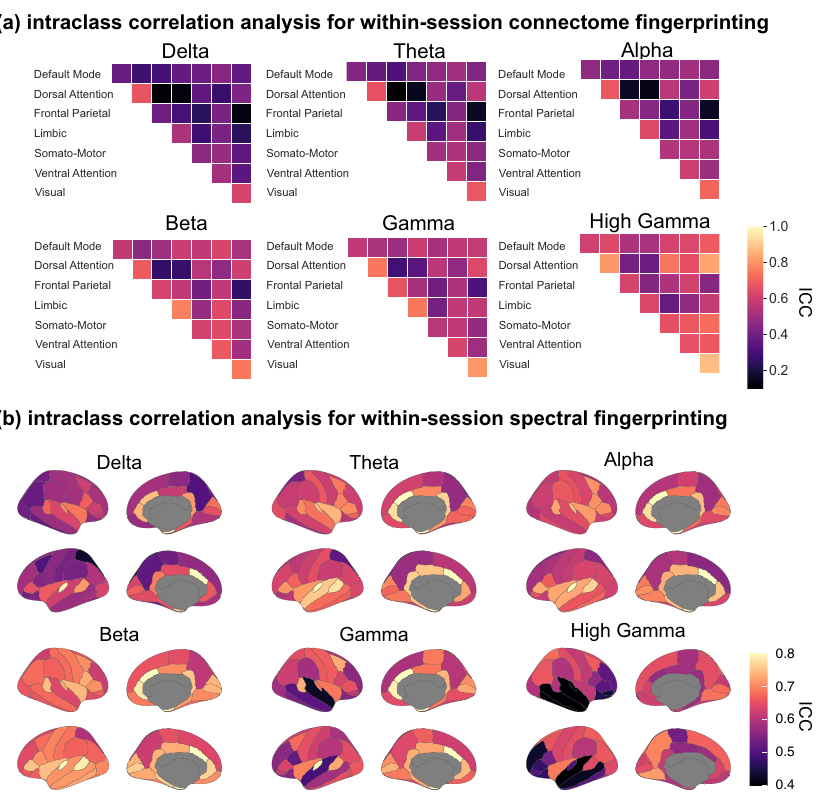
Fig. 4 Characteristic features of connectome and spectral fi ngerprinting. Intraclass correlation (ICC) for connectome and spectral within-session fi ngerprinting. a ICC for connectome fi ngerprinting plotted for each tested frequency band, using network labels from Yeo et al. 81 . The most prominent networks for connectome fi ngerprinting were the Visual, Dorsal Attention, and Limbic networks. b ICC for spectral fi ngerprinting plotted for each tested frequency band and mapped using the Desikan-Killiany cortical parcellation 37 . The most salient features were the theta, alpha, and gamma band signals expressed in midline structures and the beta band across the